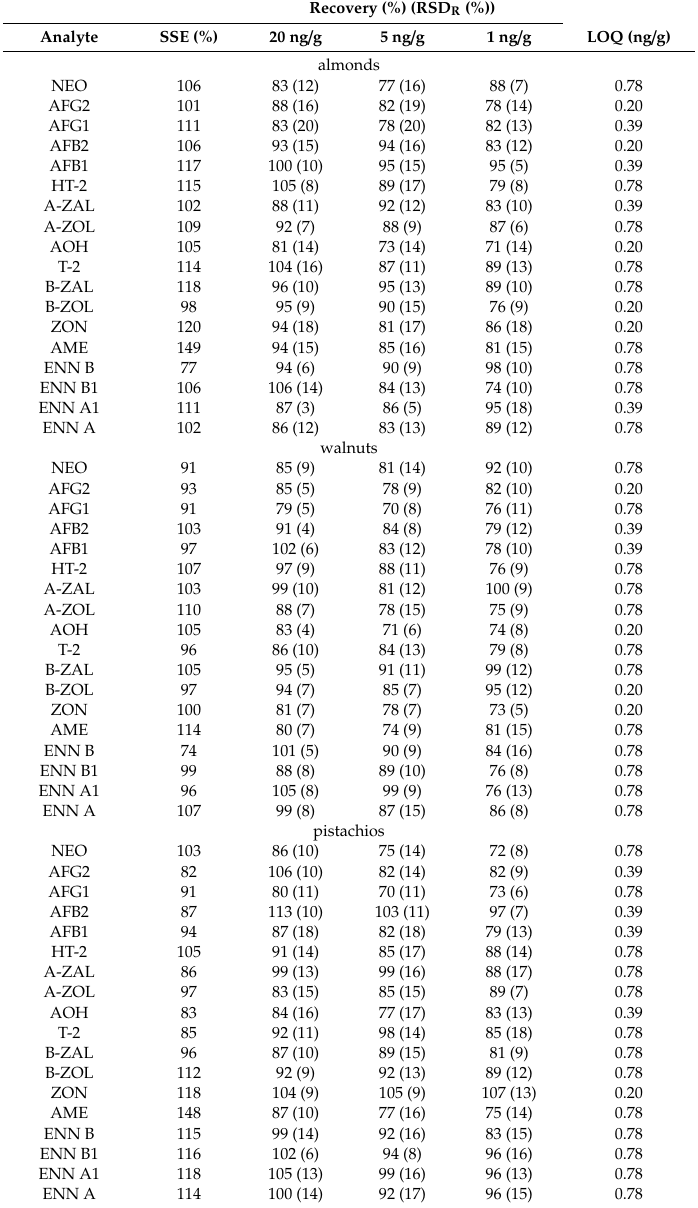
Table 1. Method performance in almonds, walnuts,